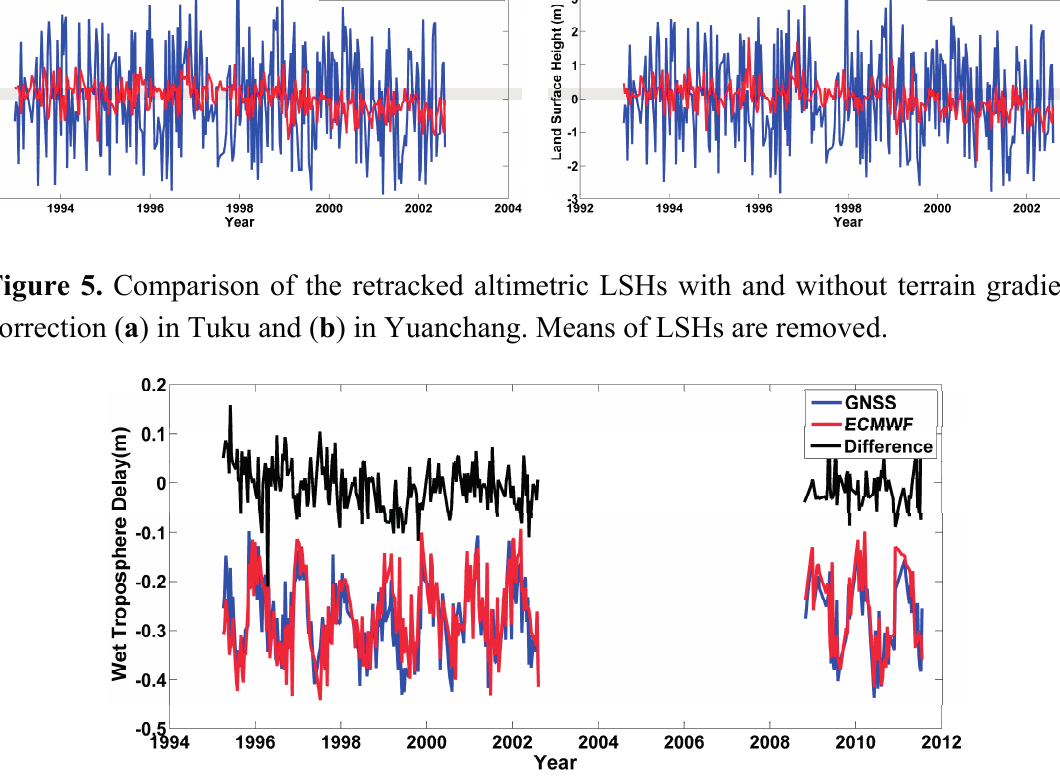
Figure 6. Comparison of wet troposphere delays derived from GNSS and ECMWF in Yuanchang. The GNSS- and water vapor radiometer (WVR)-derived wet troposphere delays were also